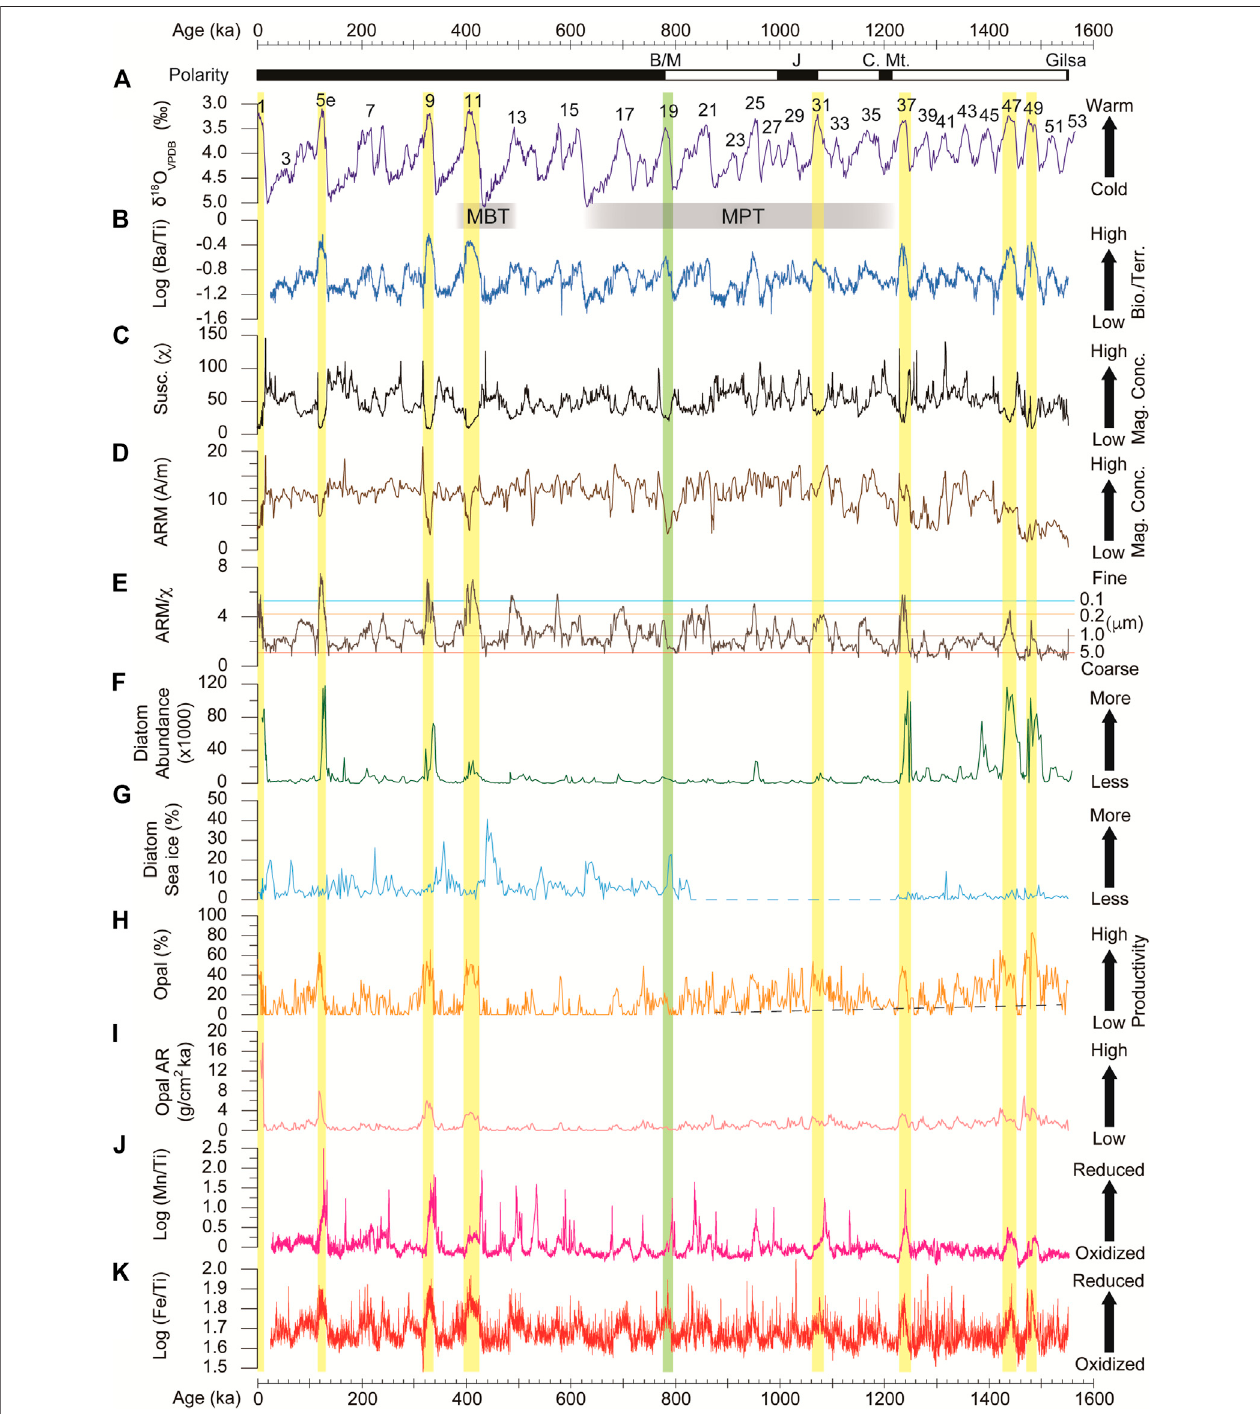
FIGURE3| TemporalvariationofenvironmentalproxyresultsfrommarinesedimentcoreMD01-2414arecomparedtothemarineoxygenisotoperecordreported by Lisiecki and Raymo (2005) since 1550 ka. Stronger interglacial periods are marked by yellow bars. Mid-Pleistocene Transition (MPT) and Mid-Brunhes Transition (MBT) are marked by Gray bars. MIS 19 is marked by green bar. (A) marine oxygen isotope (B) , log (Ba/Ti), (C) magnetic susceptibility ( χ ), (D) anhysteretic remanent magnetization (ARM), (E) ARM/ χ , (F) diatom abundance values, percentage of sea ice diatom assemblages (G) and Opal (H,I) Opal accumulation rate (AR) (J) log (Mn/Ti), and (K) log (Fe/Ti).